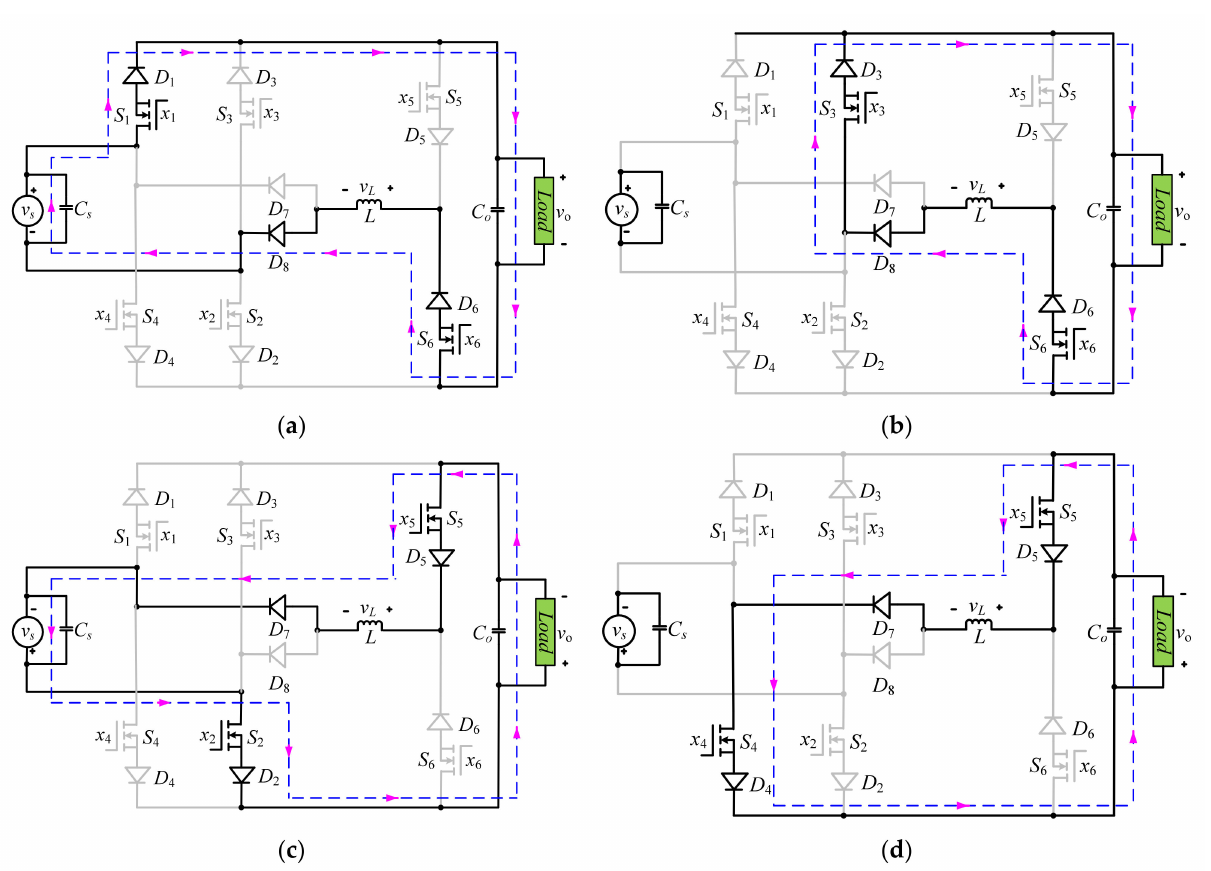
Figure 3. Equivalent current-conducting loops with respect to input voltage to produce non-inverting buck operation during; ( a , b ) positive half cycles; ( c , d ) negative half